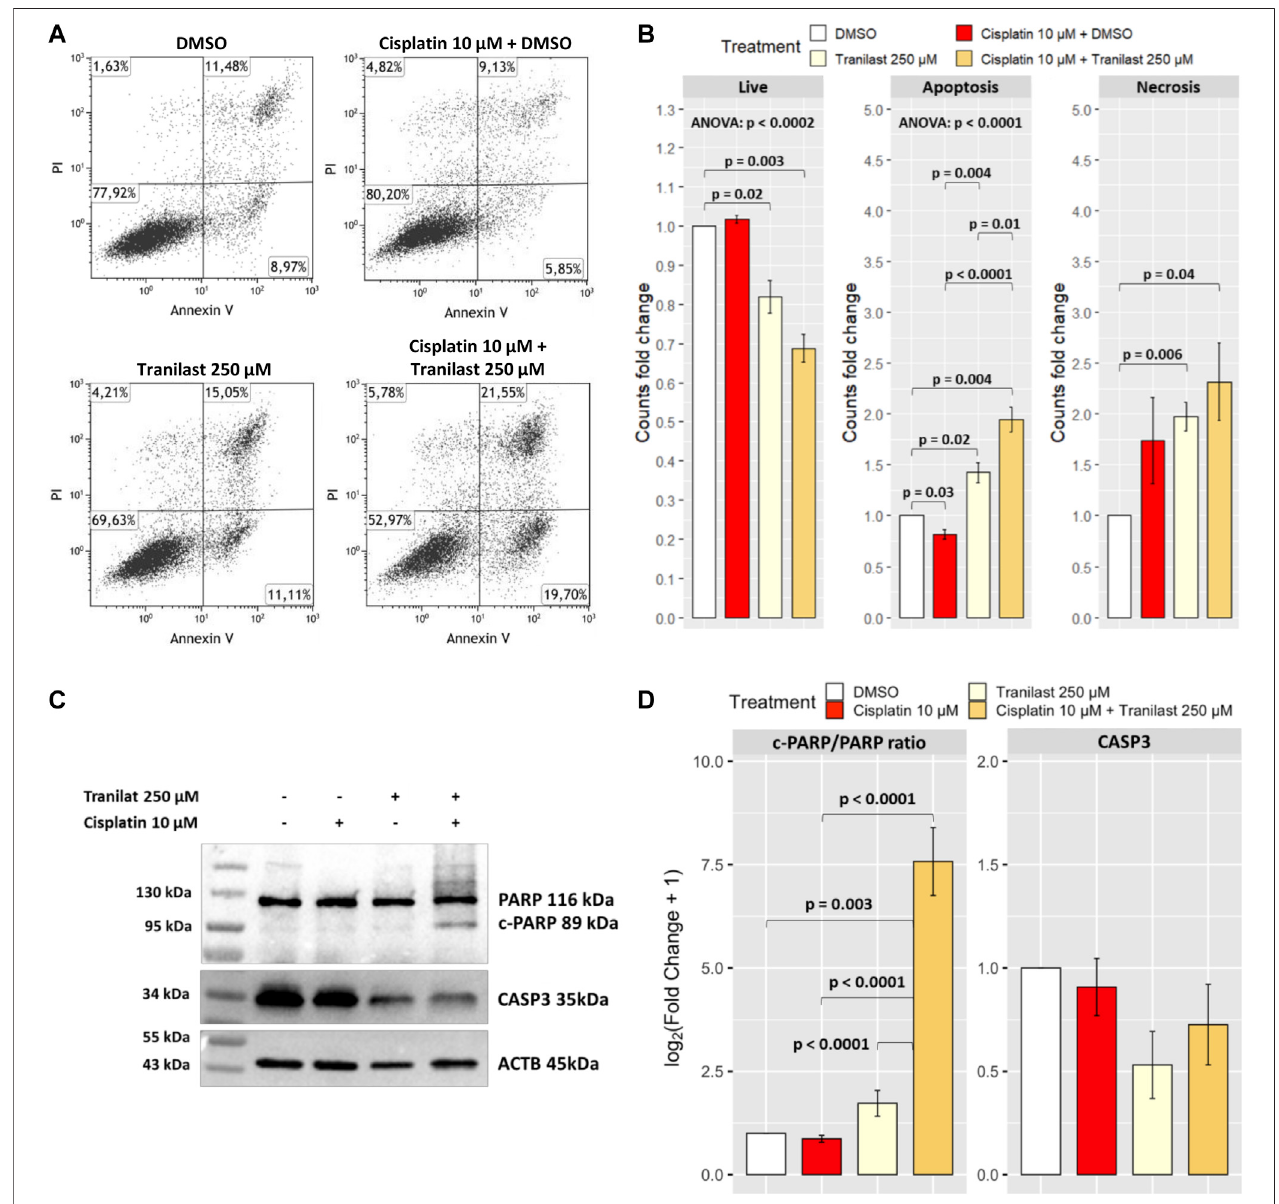
FIGURE 4 | Effect of TRPV2 chemical inhibition on apoptosis rates of KATO-III cells. (A) Representative dot plots obtained by fl ow cytometry measurement of Annexin V exposure and propidium iodide (PI) fl uorescence in different culture conditions. (B) Statistical analysis on DMSO normalized counts (fold changes) of the different types of cell death by one-sample t -test, ANOVA, and Tukey ’ s post hoc tests on three replicates. (C) Representative western blot of apoptosis activation markers in KATO-III cells treated with cisplatin, tranilast, or their combination. (D) Statistical analysis on log 2 -transformed actin-normalized densitometry data of common apoptosis markers amounts relative to cells treated with vehicle. ANOVA and Tukey ’ s tests were used to assess differences among means of treated cells, whereas one-sample t -test was used for comparison with the vehicle. Data were obtained from triplicates.